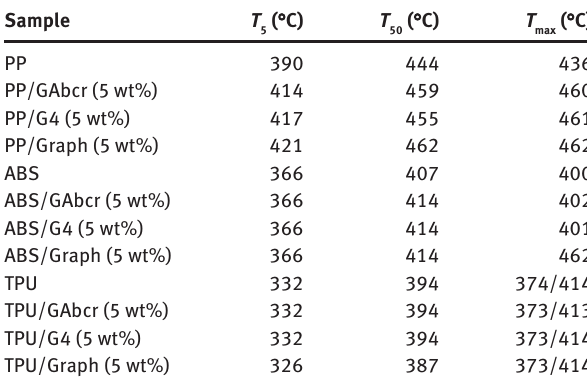
Table 5: Thermal properties of GNP- and graphite-based polymer nanocomposites